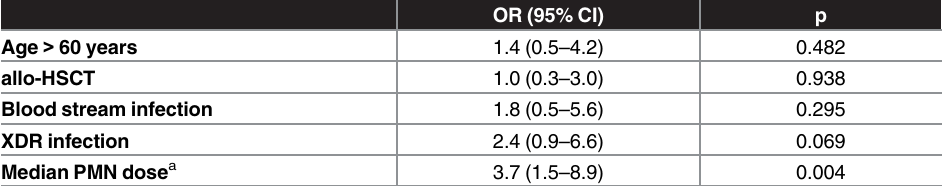
Table 5. Combined effect of clinical and transfusion parameters on infection-related mortality and survival